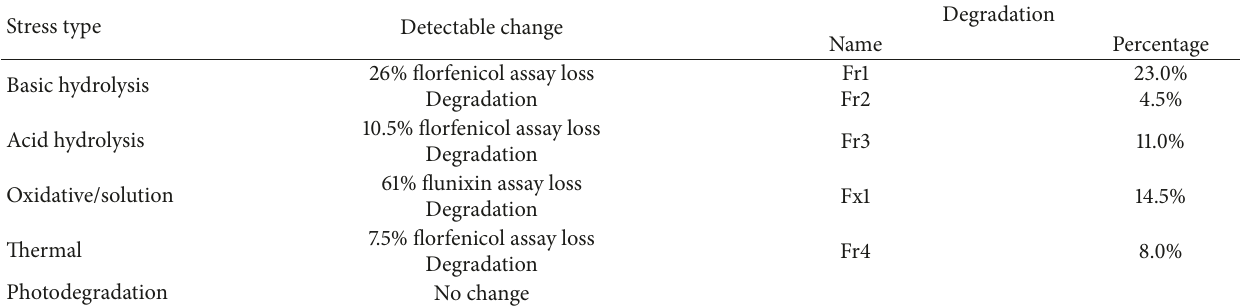
Table 3: The results of stress testing of Flr and Flx under various conditions.